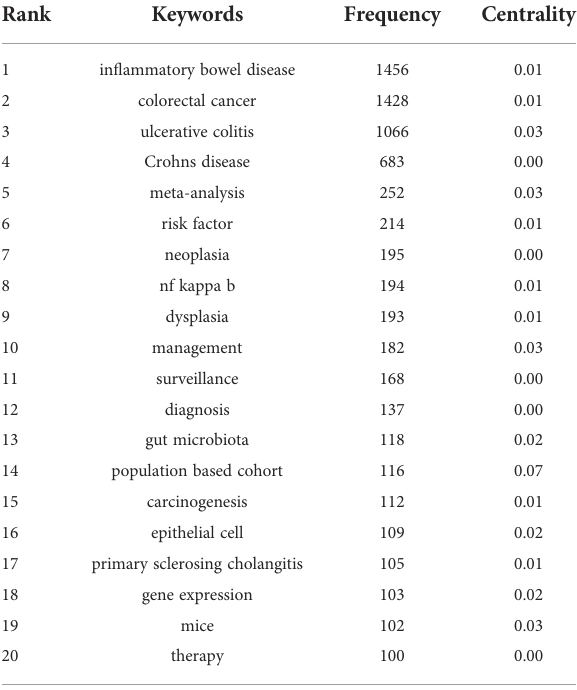
TABLE 2 Top 20 keywords in terms of frequency and